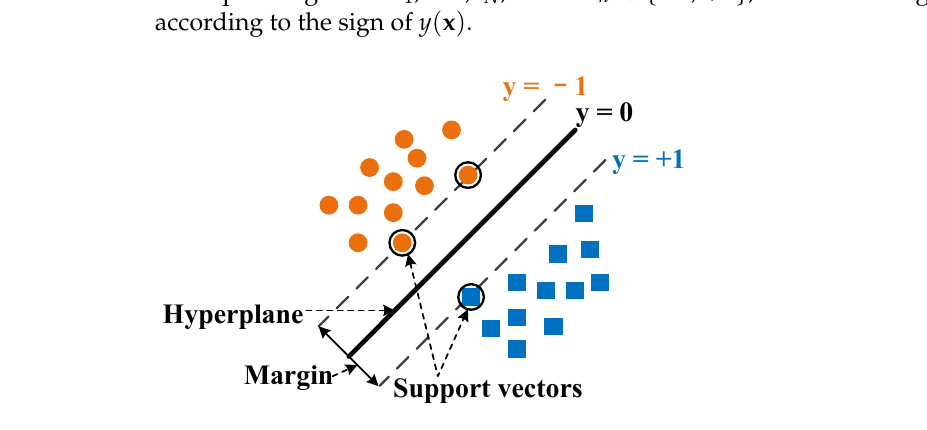
Figure 2. Example of binary SVM.